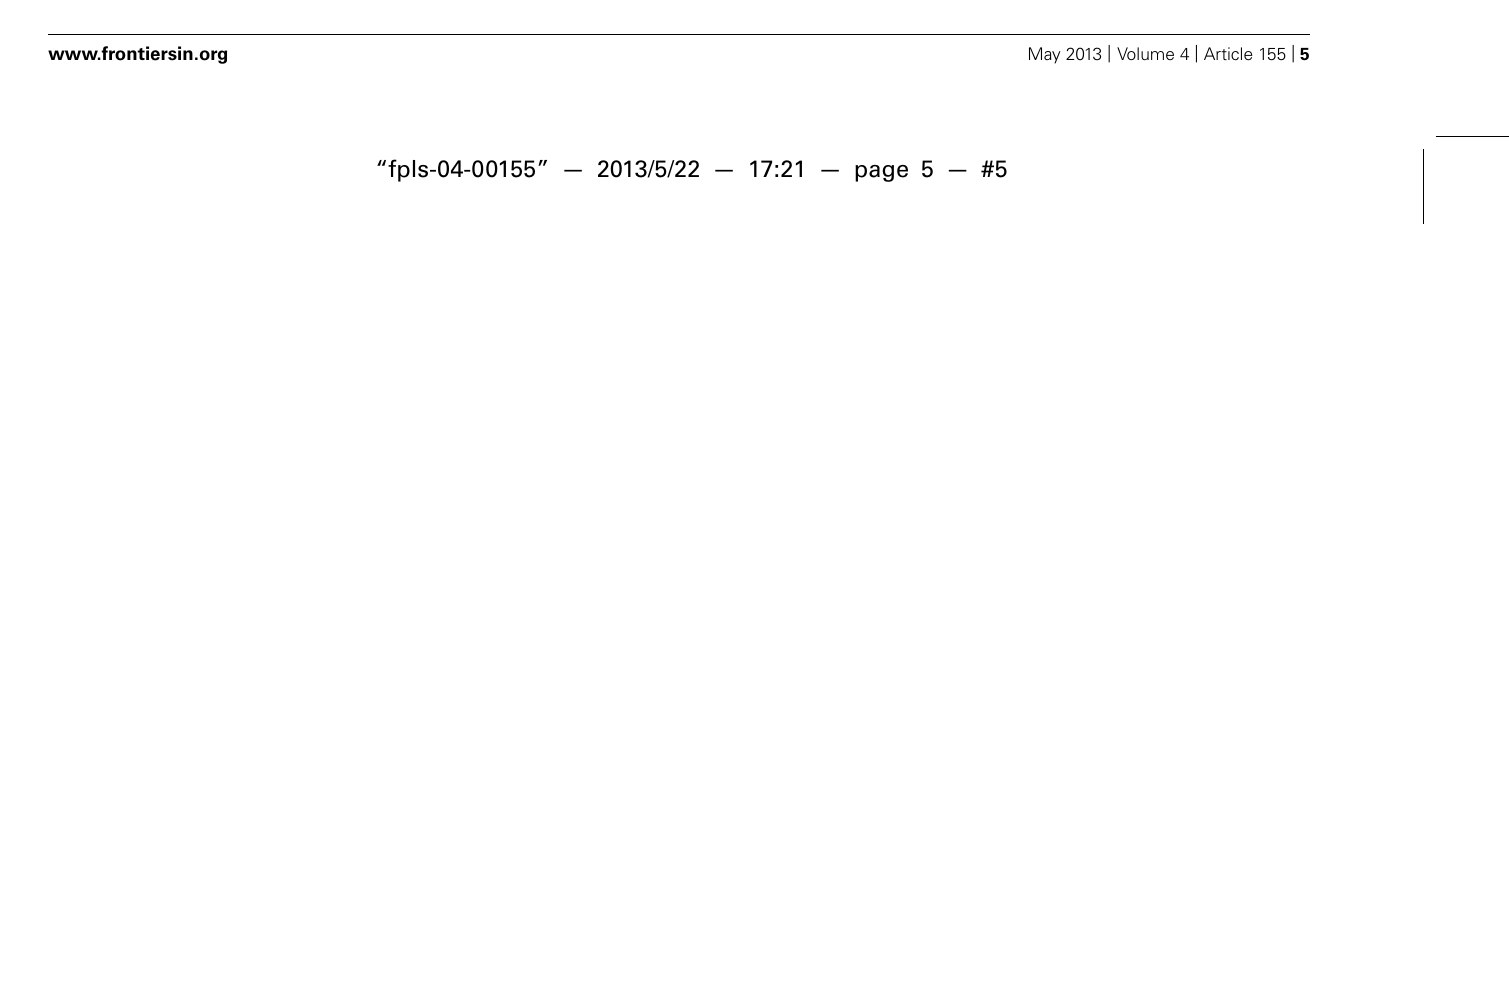
host cells, some effectors specifically bind to (underlined), induce and/or decrease (arrows/crossed lines) target gene expression or protein activity. Consequently, ABA-, SA-, or Auxin-mediated defense mechanisms are